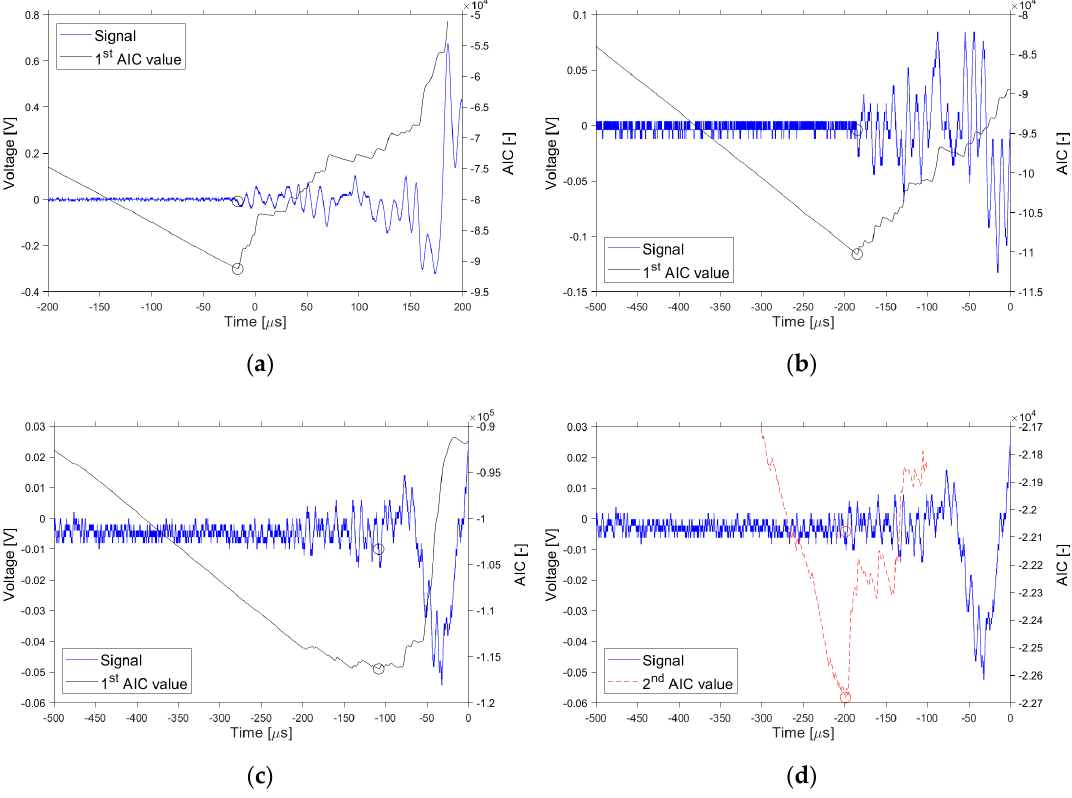
Figure 10. The onset times estimated using the single-stage AIC method for the hit sources on the raft top ( a ), under the bottom raft ( b ), and in the middle of the pile ( c ). The hit was located at Pile #14. Additionally, ( d ) the improved onset time estimated using the two-stage AIC method for the same hit in ( c ). The vertical (voltage) resolution in the 8-bit A/D converter was ~7.81 mV for the acquired signals in ( a ) and ( b ), and ~1.95 mV for the acquired signals in ( c ) and ( d ). The horizontal (time) interval was ~60 ns.